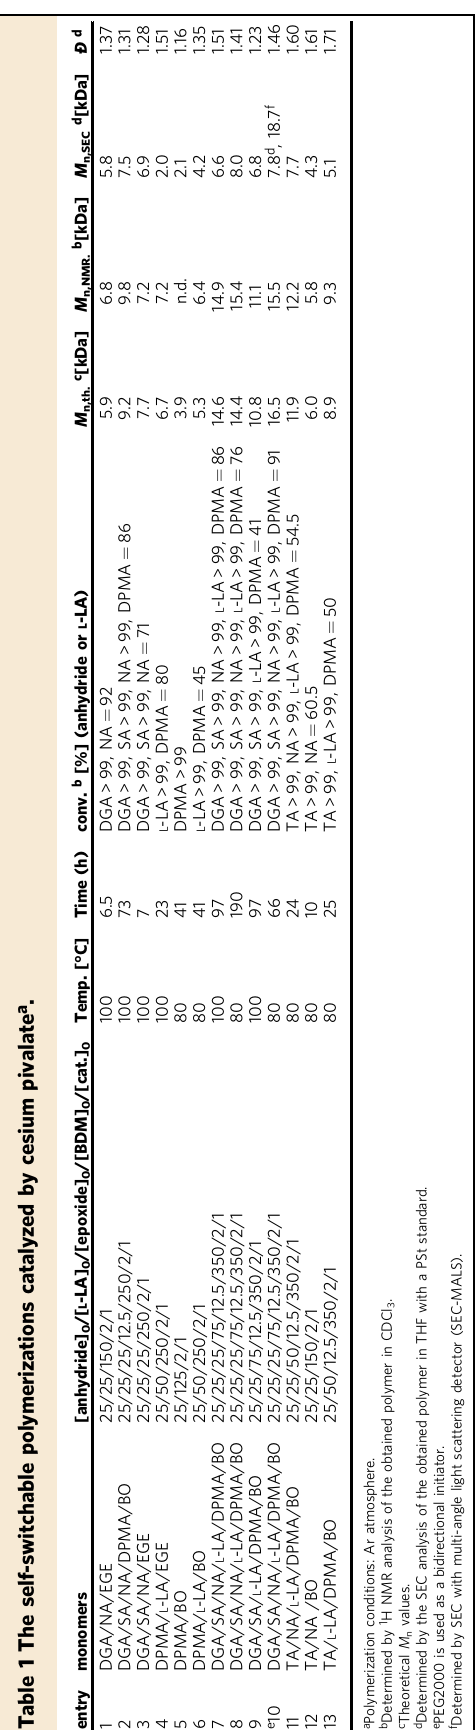
Fig. 28) representing PLLA. During this period, no broad peak is observed at 6.12 – 5.96 ppm (protons 8 and 9, Supplementary Fig. 28), and the signals at 6.08 and 6.00 ppm representing DPMA remain unchanged, indicating that DPMA remains unreacted, with no P(DPMA- alt -EGE) block formation. The ROCOP of DPMA/EGE only commences after L -LA is completely consumed, fi nally producing a P(DPMA- alt -EGE)- b -PLLA- b -P(DPMA- alt - EGE) triblock copolymer (Supplementary Figs. 28 – 32). The nonterminal model yielded reactivity ratios (Supplementary = 831.91 ± 49.22 and r = 0.0069 ± 0.0002), Fig. 33, r L (cid:1) LA DPMA which con fi rmed that the perfect triblock copolymer should be formed. The analysis of SEC showed that the resultant copolymer shows ill-de fi ned features, such as a broad monomodal Ð (1.51, entry 4 in Table 1 and Supplementary Fig. 31). This is due to that transesteri fi cation or back-biting reactions could occur during polymerization for DPMA/ L -LA/EGE system. ROCOP of DPMA/ BO provided a well-de fi ned copolymer with monomodal mole- cular weight distribution and a narrow Ð (1.16, entry 5 in Table 1 and Supplementary Figs. 34 – 36). The polymerization from the mixture of DPMA/ L -LA/BO was carried out at 80 °C, and the resultant triblock polymer displayed the better controllability ( Ð = 1.35, entry 6 in Table 1 and Supplementary Figs. 37 – 39) relative to DPMA/ L -LA/EGE system. This result indicated that side reactions such as transesteri fi cation or back-biting reactions can be suppressed by lowering reaction temperature. The poly- merization system displays an unprecedented propagation path- way stemming from the far-higher reactivity of L -LA than that of DPMA, with the very low reactivity of DPMA attributed to steric hindrance. Therefore, the polymerization order can be freely manipulated between anhydride/epoxide ROCOP and L -LA ROP using differences in the reactivities of the monomers (Fig. 4). T